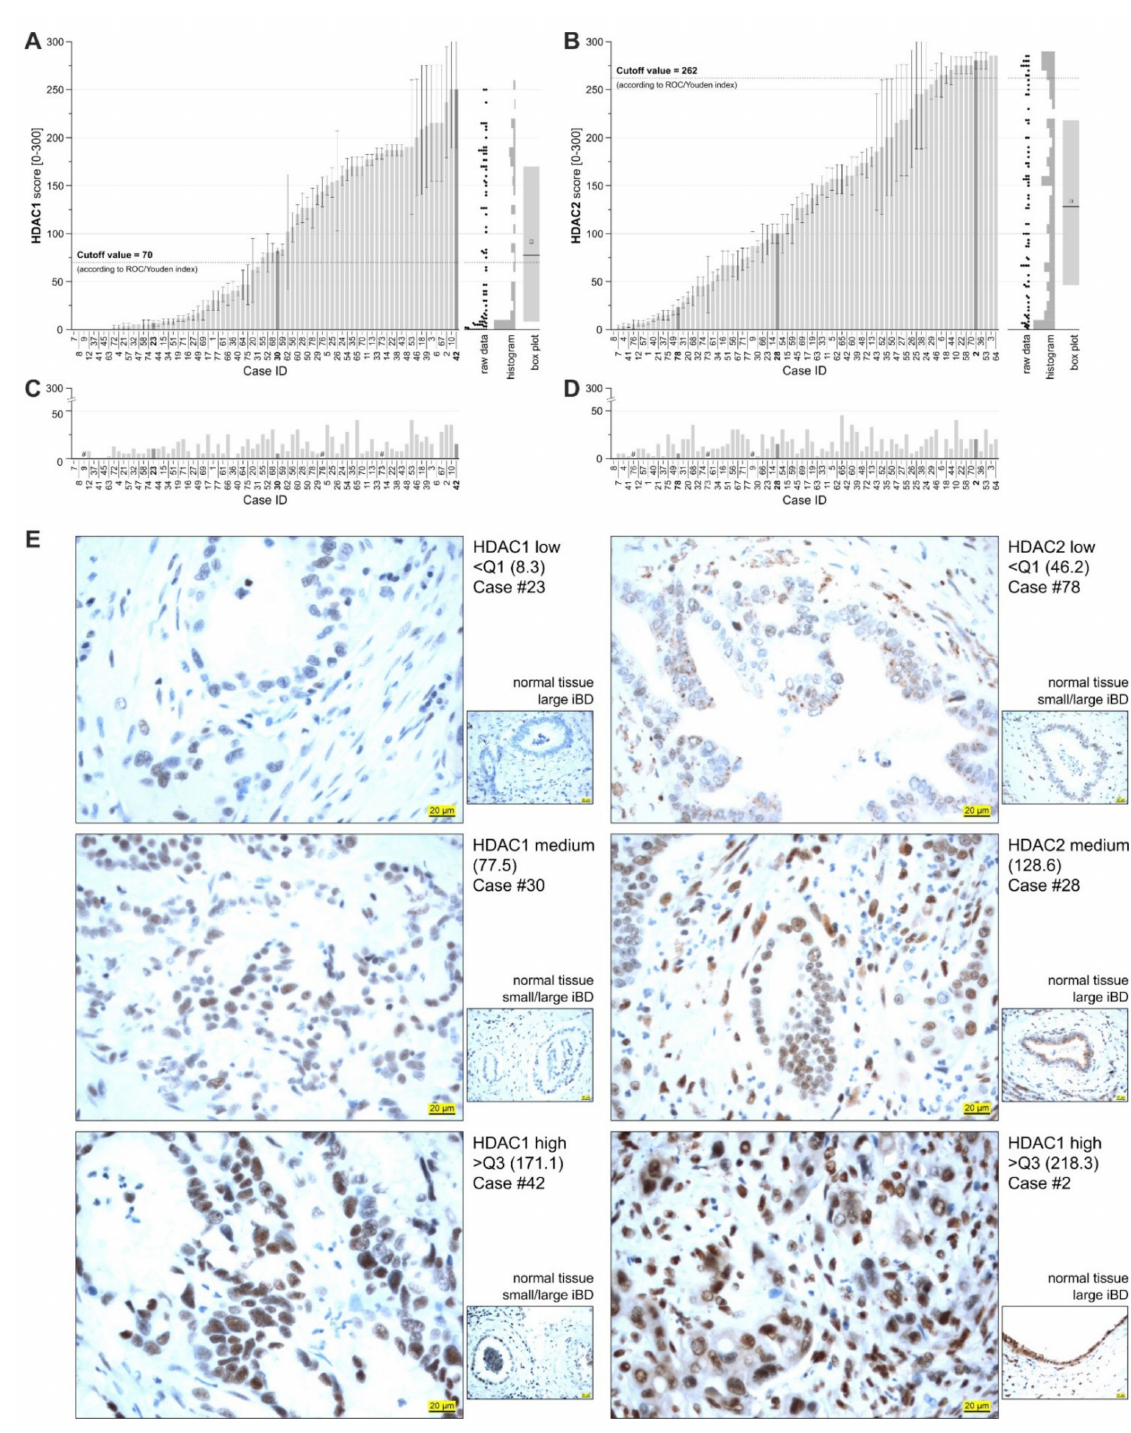
Figure 7. HDAC 1 and 2 are heterogeneously expressed in BTC patient samples. ( A , B ) Mean HDAC 1 ( A ) and HDAC 2 ( B ) expression (mean HDAC 1/2 IHC score) of the n = 78 BTC cases. Mean HDAC 1/2 IHC scores were calculated based on staining intensity and extensity for three different areas of the specimen. Box plots indicate the 25/75 percentiles. ( C , D ) Mean HDAC 1 ( C ) and HDAC 2 ( D ) expression (mean HDAC 1/2 IHC score) of adjacent non-tumor tissue. # = adjacent non-tumor tissue not present on tissue sample. ( E ) Representative IHC images of BTC cases for HDAC 1 (low, medium, high; left panel) and HDAC 2 (low, medium, high; right panel) as well as adjacent non-tumor tissue, respectively. Scale bar (yellow) indicates 20 µ m for 40 × magnification. Abbreviations: BTC, biliary tract cancer; IHC,